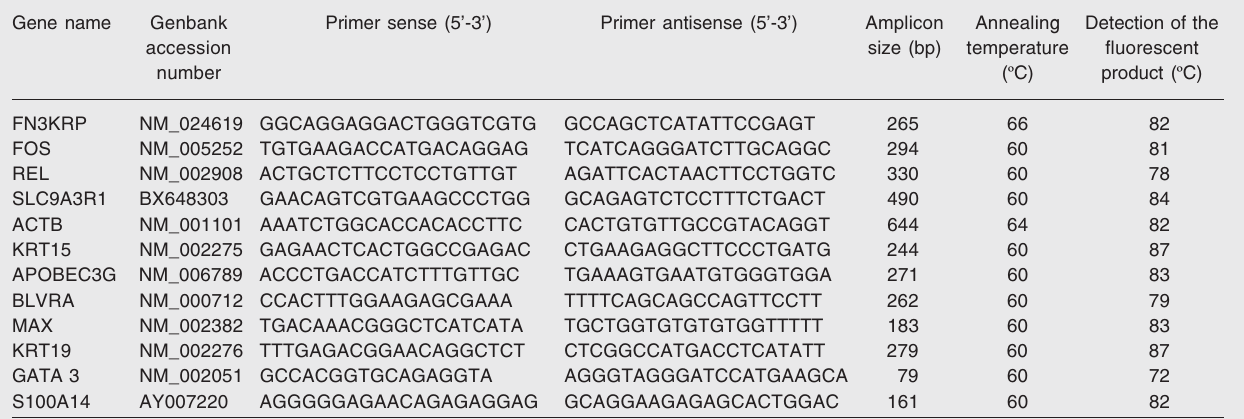
Table 2. Sequences of primers and probes and conditions of quantitative